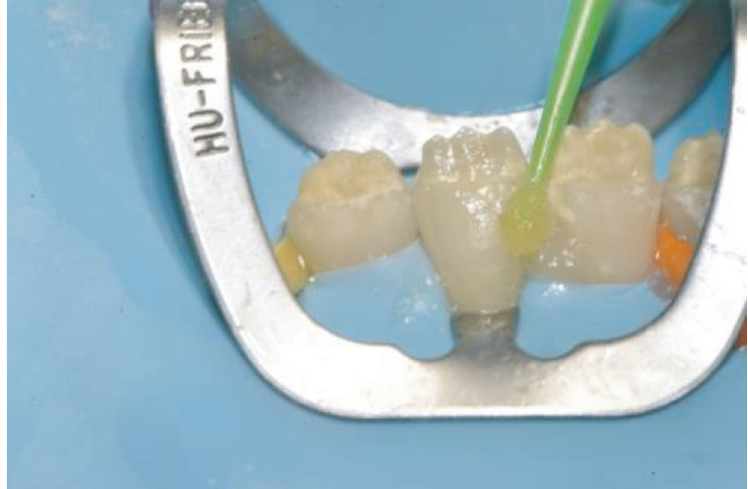
Figure 10: Application of single-component adhesive.